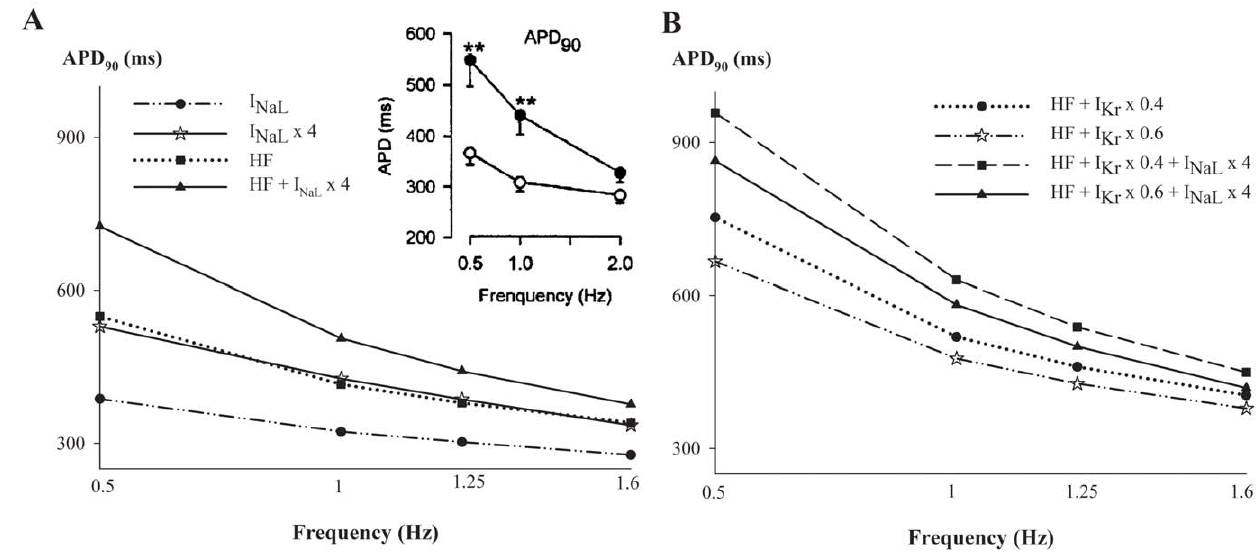
Figure 6. Role of I NaL in APD rate-dependence in HF and reduced repolarization reserve. Simulated APD dependence on stimulation frequency for normal (circles in panel A) and HF (squares in panel A) conditions and in the presence of enhanced I NaL in normal (stars in panel A) and HF (triangles in panel A) conditions. The inset shows experimental results of Li et al. [7]. Panel B, depicts the APD rate-dependence for HF combined with different degrees of I Kr inhibition and I NaL enhancement.